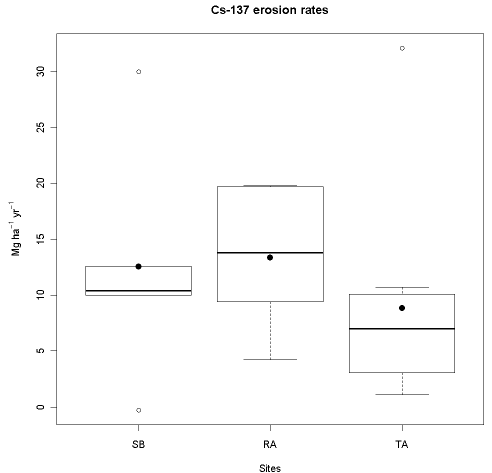
Fig. 9. Soil erosion rates found in the three sites: Snow Bridge area (SB); Release Area (RA); Track Area (TA) that includes the mean value of all the points belonging from T1 and T2. The dark full circles denote mean values, the blank dark circles represent outliers (i.e. more than 1.5 times the interquartile distance), and the black line is the